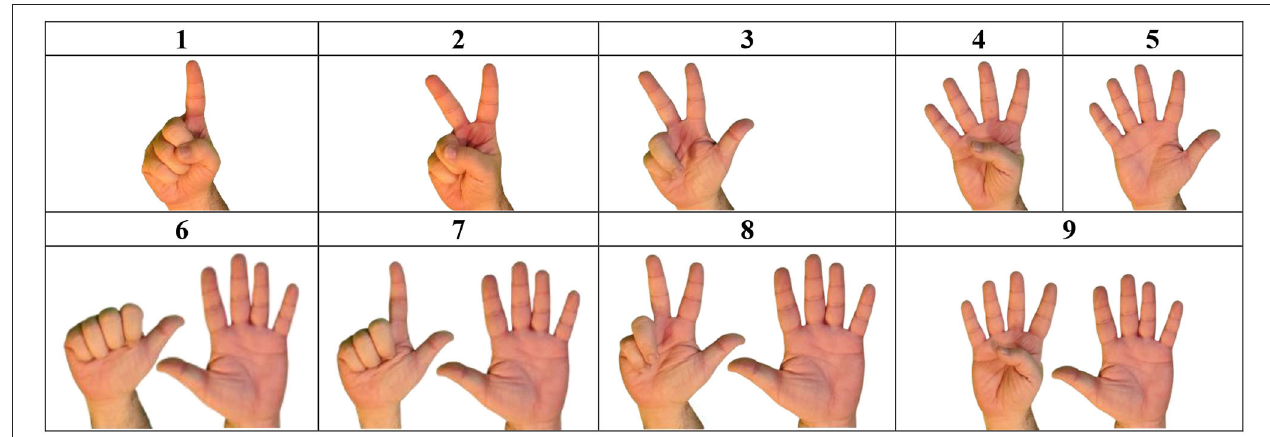
FIGURE 2 | Numbers 1–9 in ISL illustrating phonological similarities between number-signs (e.g., the similarity between 3-8 and 4-9. See Appendix for variants of some of the number-signs).